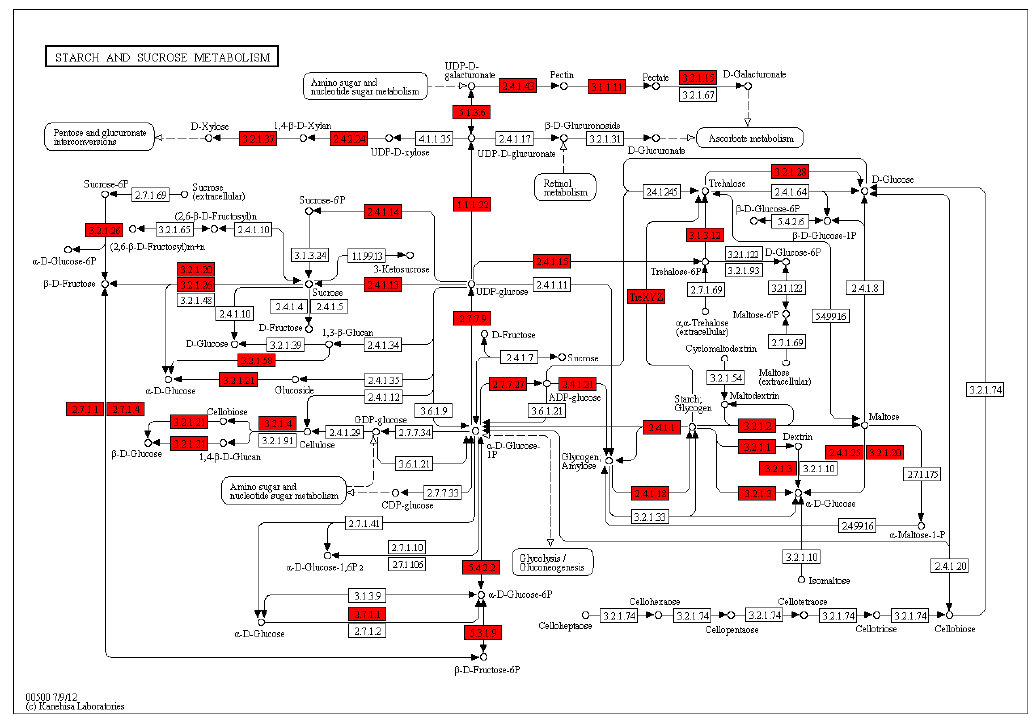
Figure 22. Starch and sucrose metabolism pathway. The red boxes indicate Unigenes were assigned to the enzymes.